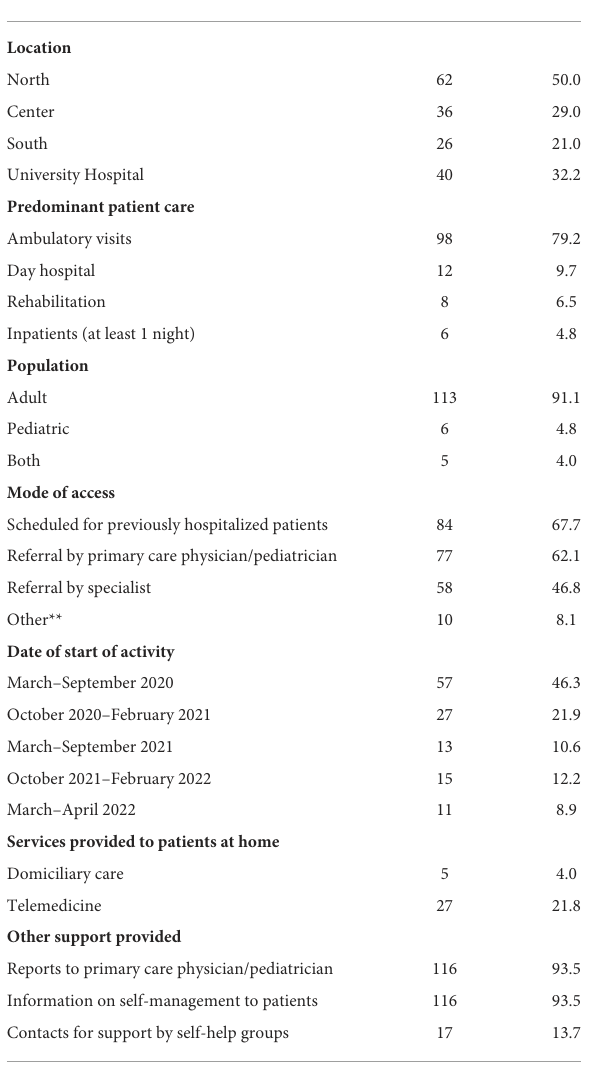
TABLE 1 General characteristics of the Long-COVID care